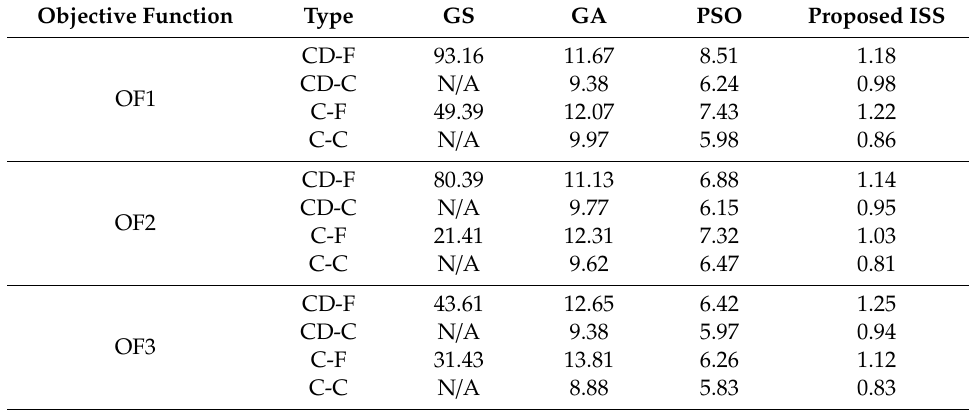
Table 5. Computational time for a single EV for the methods under four charging modes (In seconds).